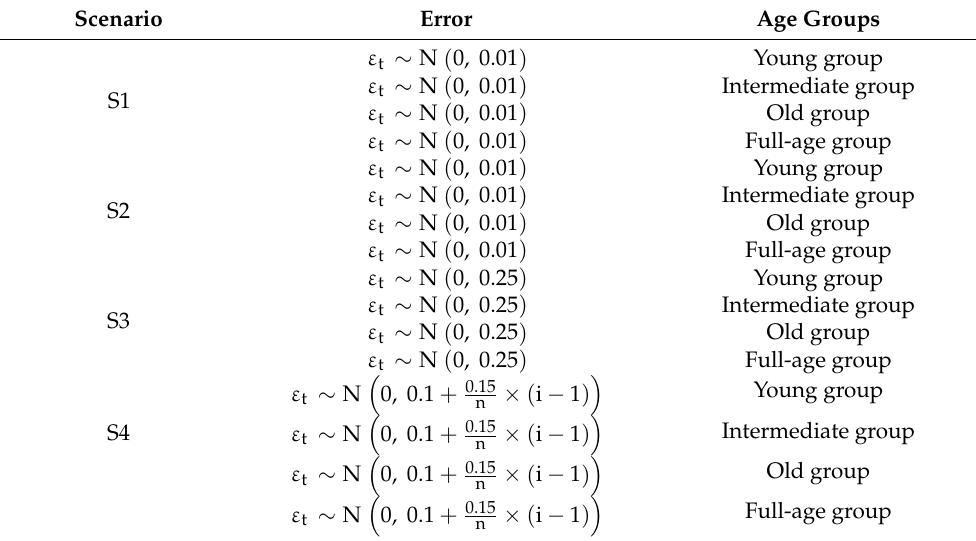
Table 3. Error settings of different observation